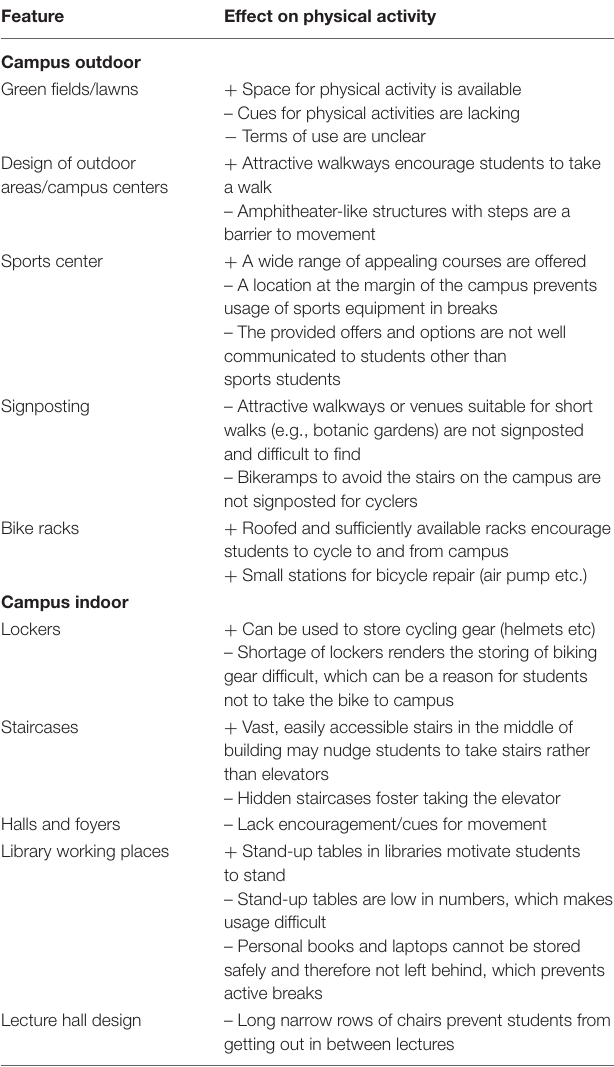
TABLE 3 | Summary of